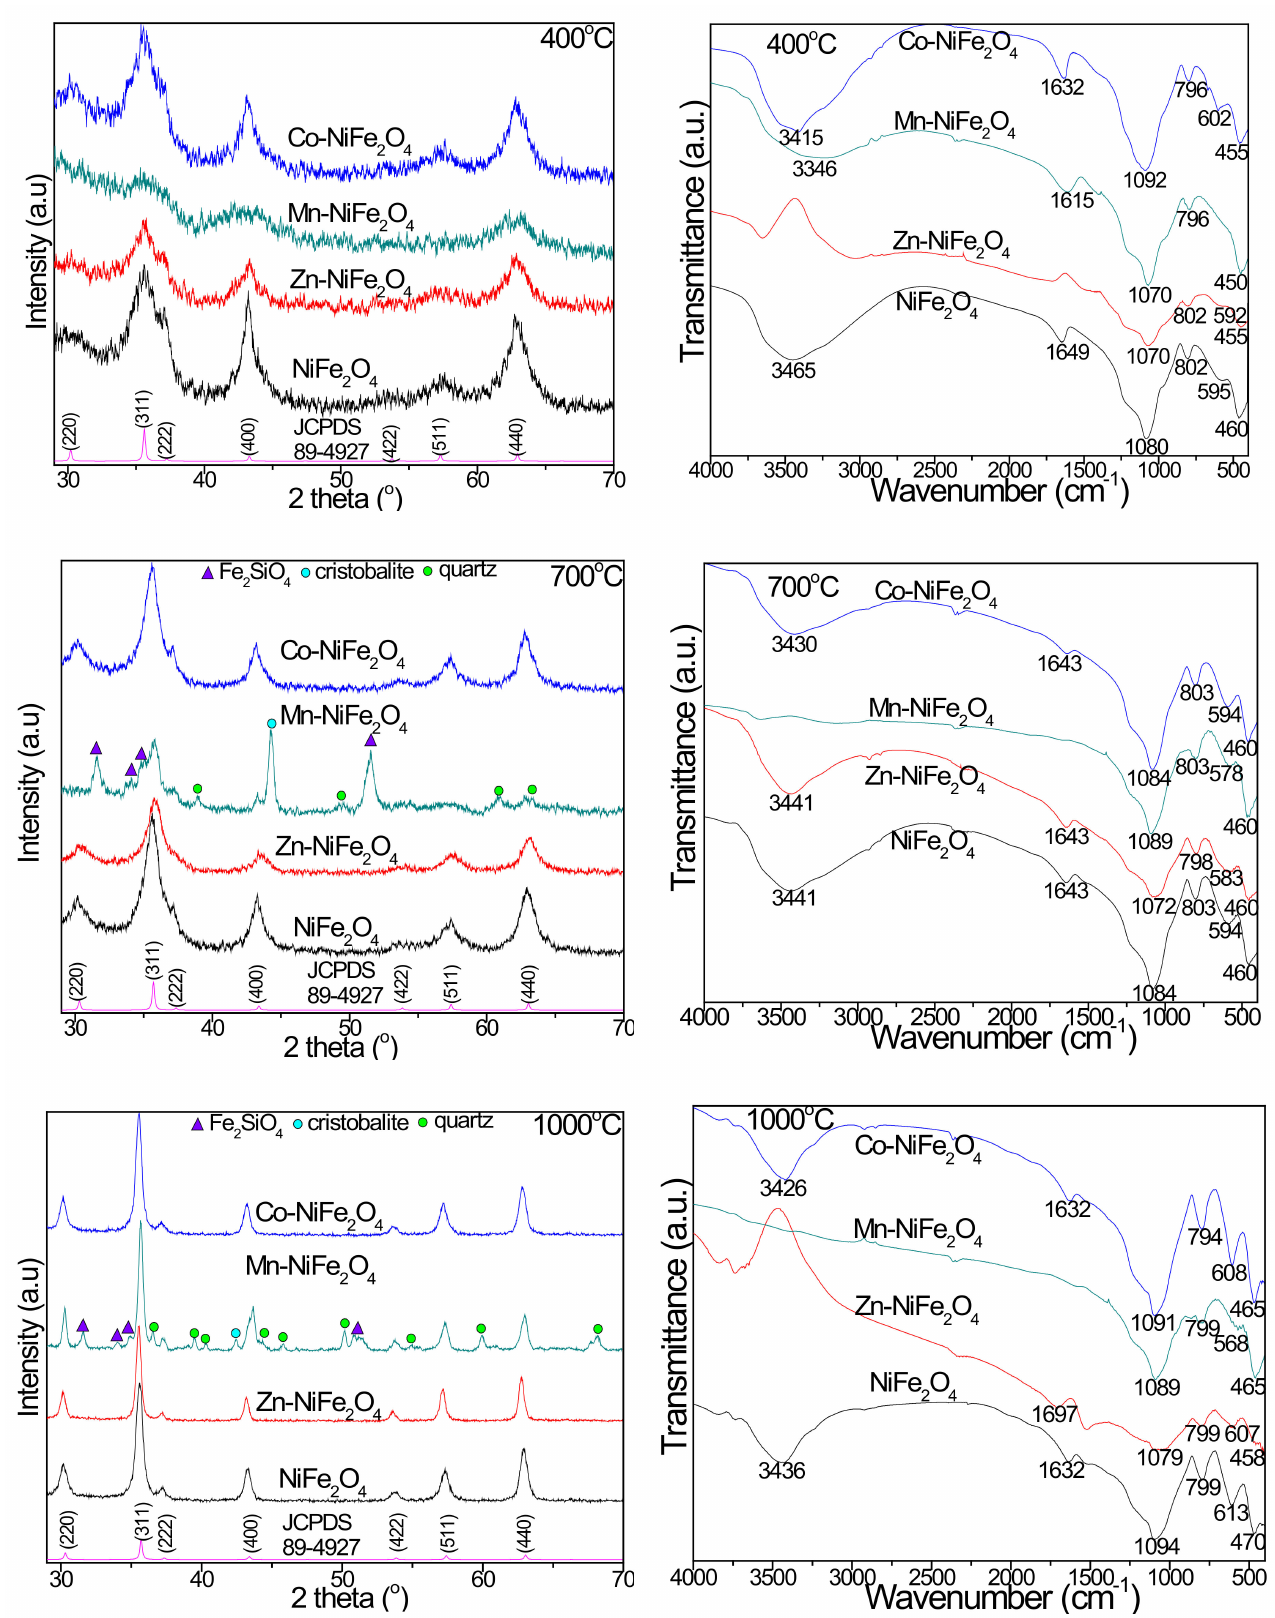
Figure 4. XRD patterns and FT-IR spectra of virgin and doped NiFe 2 O 4 (Zn-NiFe 2 O 4 , Mn-NiFe 2 O 4 , Co-NiFe 2 O 4 ) samples annealed at 400, 700, and 1000 ◦